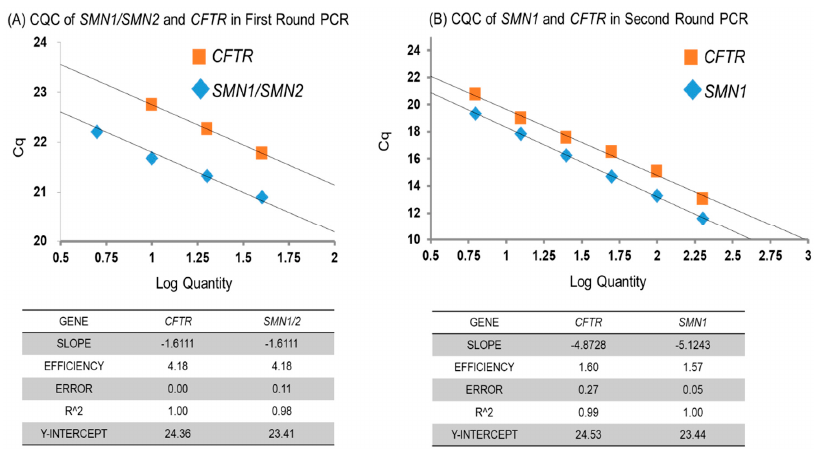
Figure 2. Cq-Log quantity curves (CQC). ( A ) Cq-Log quantity curves of SMN1 / SMN2 ( SMN1 and SMN2 fragments amplified by the same primers) and CFTR in the first round PCR. The amplification e ffi ciencies of the CFTR and SMN1 / SMN2 were similar. ( B ) SMN1 and CFTR in the second round PCR. The amplification e ffi ciencies of the SMN1 and CFTR were also